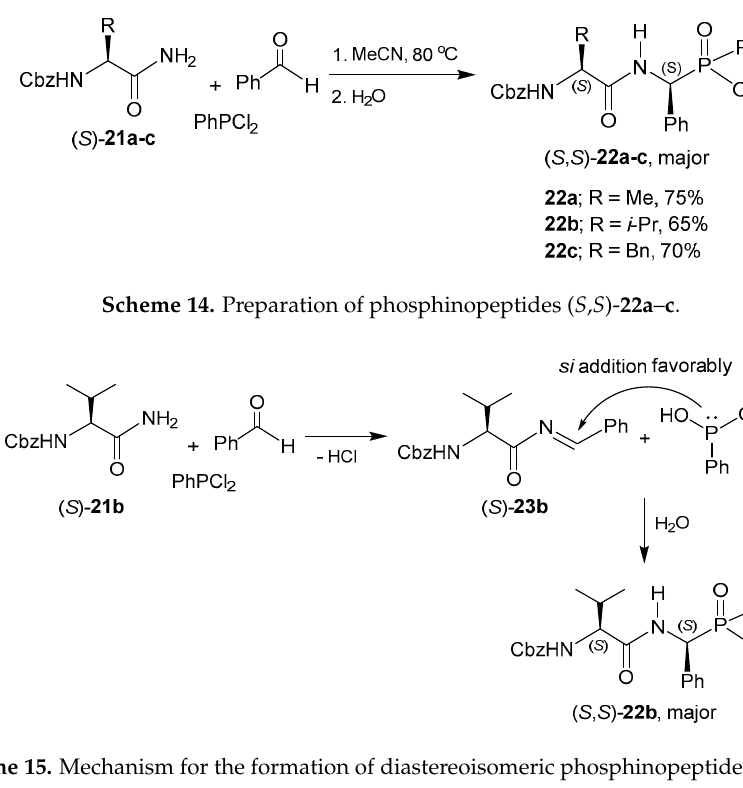
Molecules 2016 , 21 , 1141 8 of 29 2.2. Stereoselective C-P Bond Formation (One-Pot Three-Component Reaction) 2.2.1. Chiral Amino Compounds Possibly the simplest experimental proposal to prepare optically active α -amino- C -phosphinates is the “one-pot” three-component reaction, where the reactants are placed all together with or without solvent and catalyst, which is identical to the Kabachnik-Fields reaction widely studied in the synthesis of α -aminophosphonates [50–52]. Meng and Xu [19] reported a direct synthetic route for the preparation of